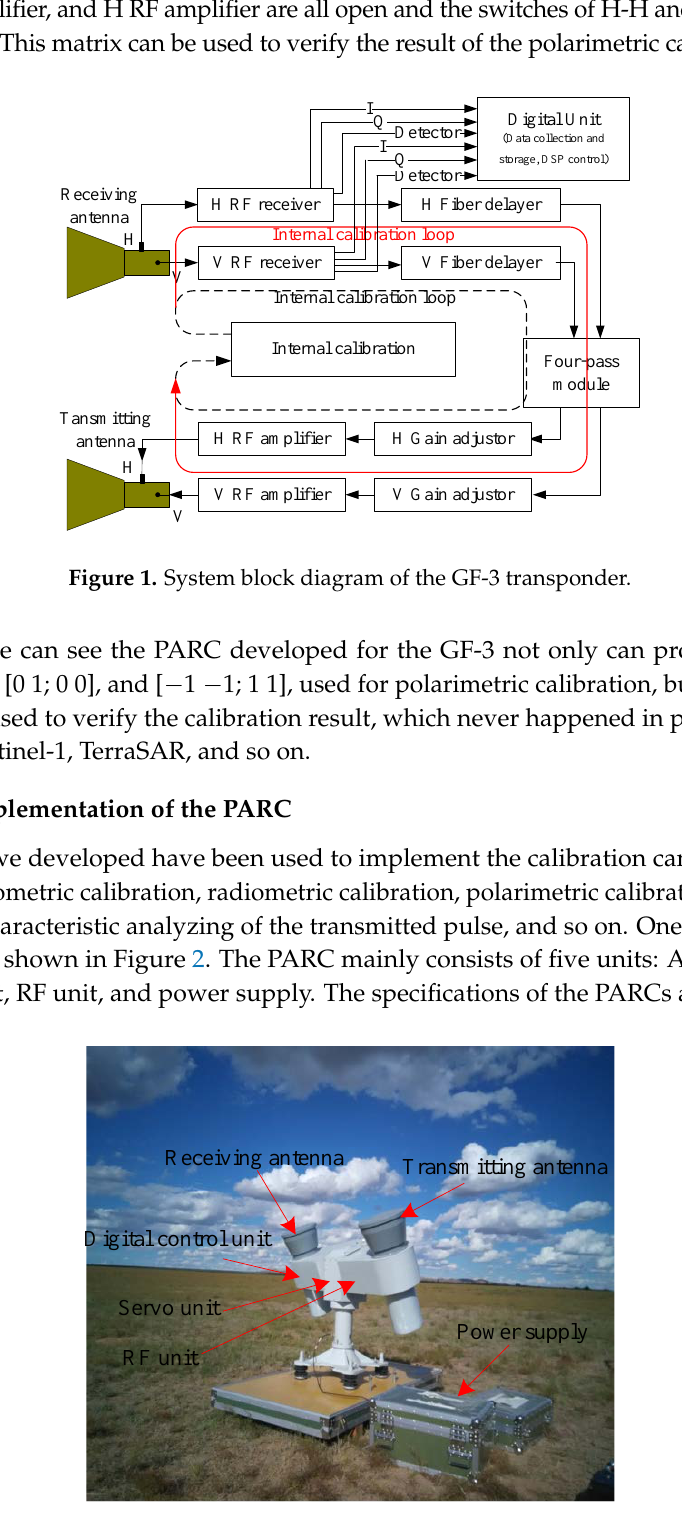
Figure 2. The transponder in the calibration field.